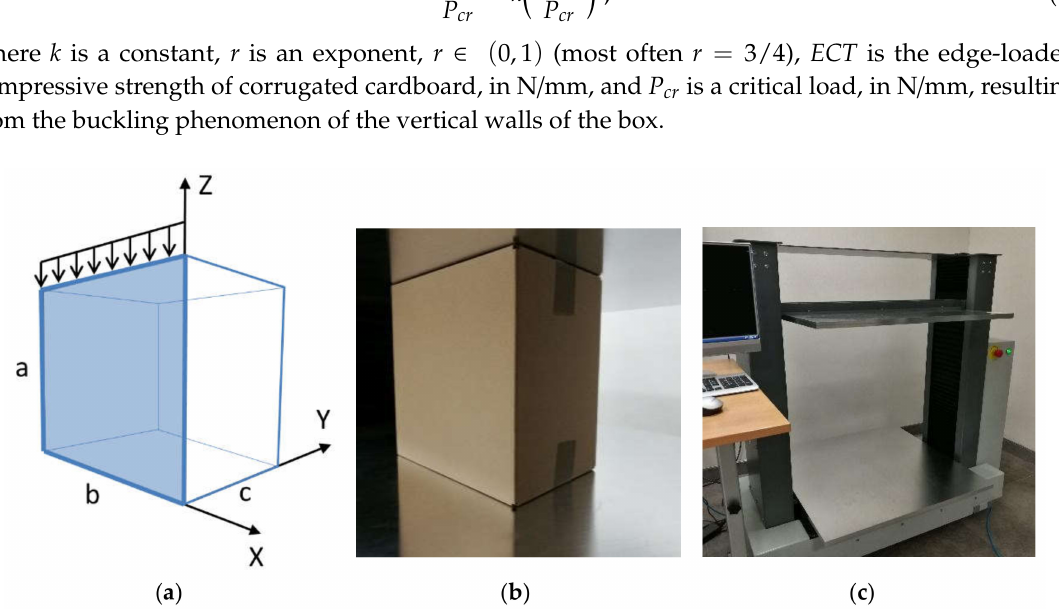
Figure 1. ( a ) A single panel of width b and height a separated from cardboard packaging as a supported plate under compression; ( b ) cardboard packaging in press during box compression testing; ( c ) box compression press used in laboratory tests